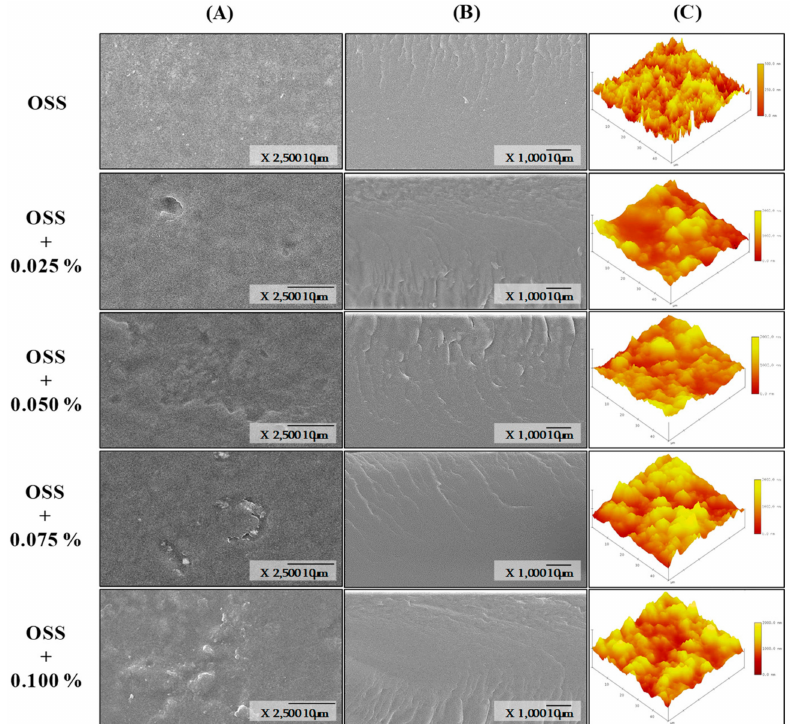
Figure 4. Scanning electron micrographs of octenyl succinate starch films with pecan nutshell extract, surface ( A ), cross-section) ( B ), and surface topography ( C ). OSS: Octenyl succinate starch.